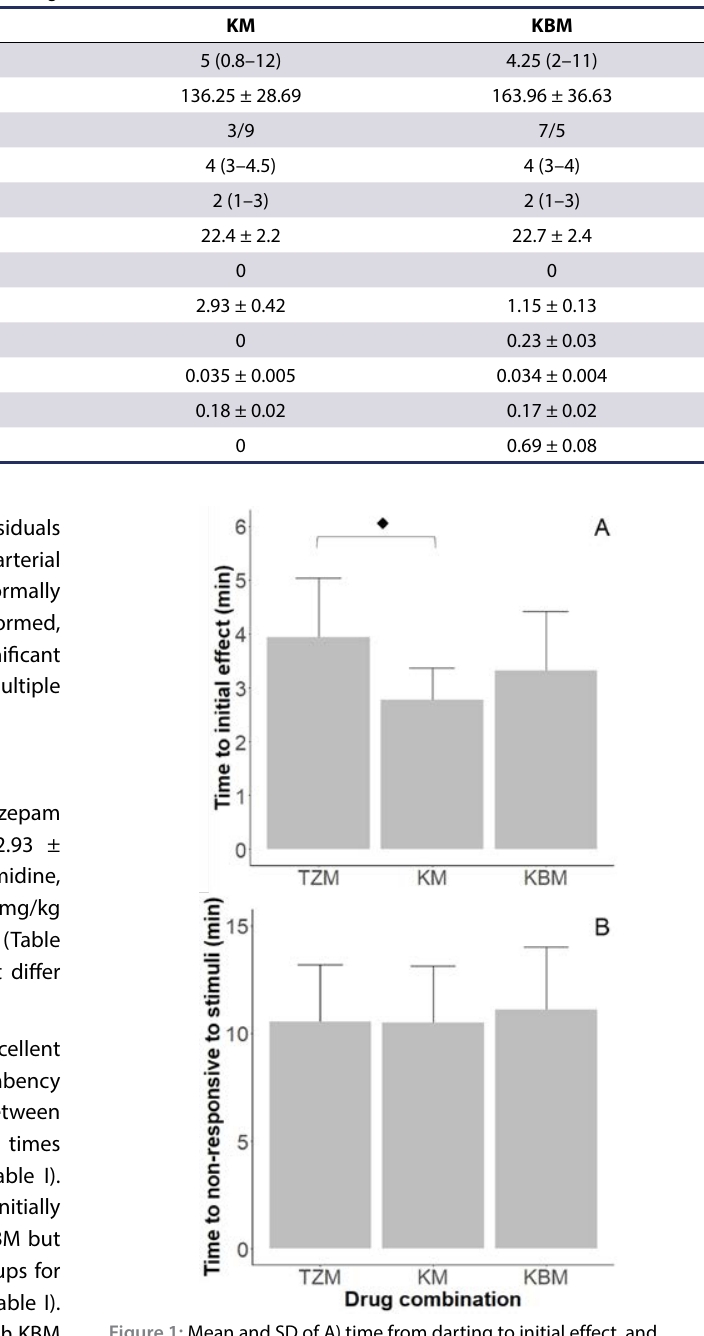
Table II: Lion data: age, body mass, sex, body condition, belly size scored, ambient temperature and doses of immobilisation drugs administered. Immobilisation was induced intramuscularly with tiletamine-zolazepam-medetomidine (TZM), ketamine-medetomidine (KM) or ketamine-